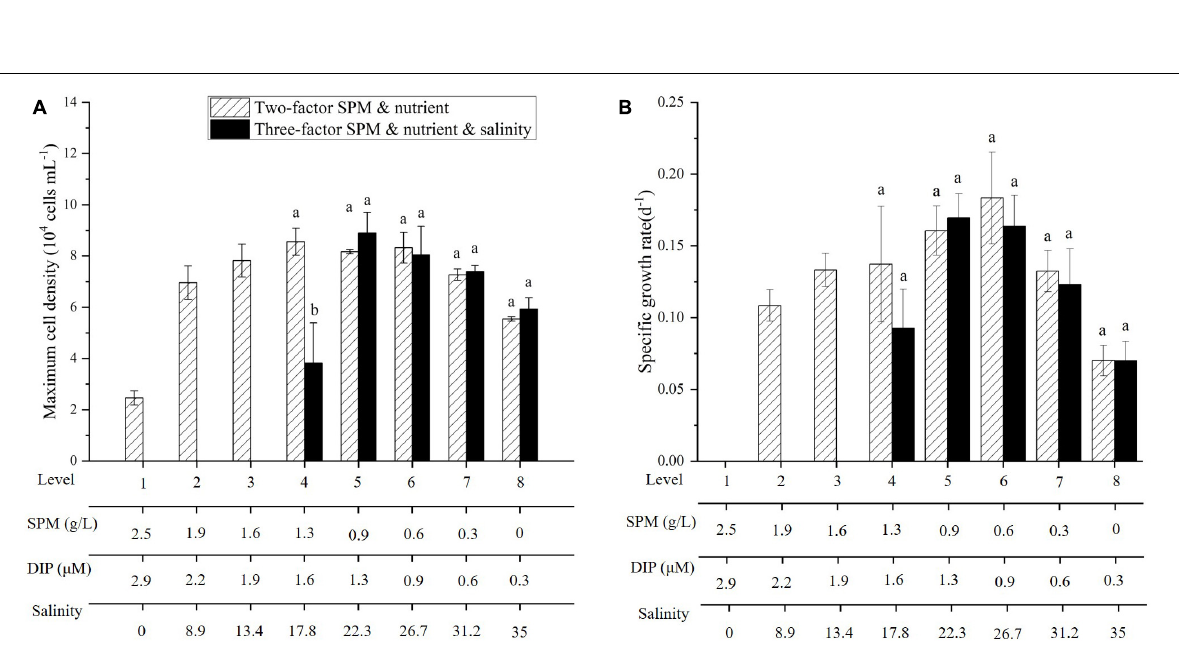
Frontiers in Marine Science |